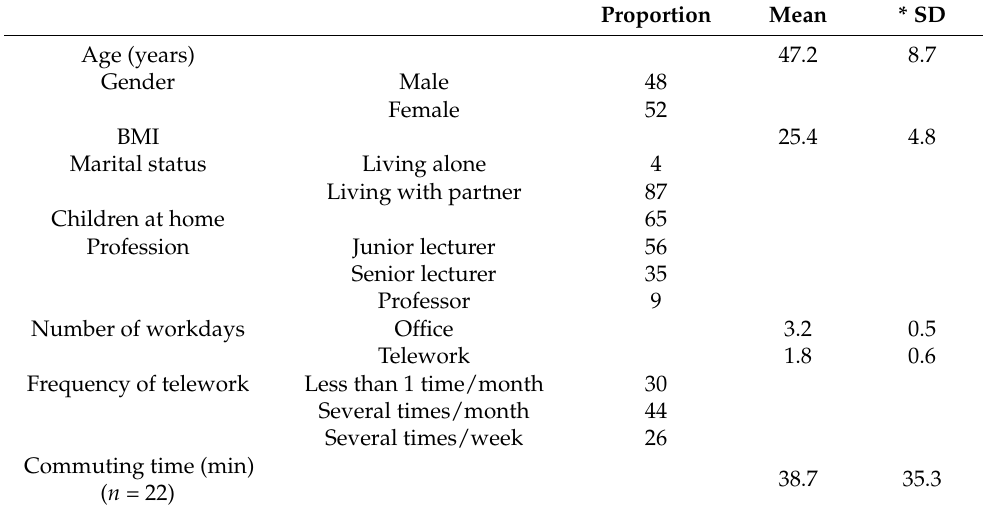
Table 1. Sample characteristics ( n =